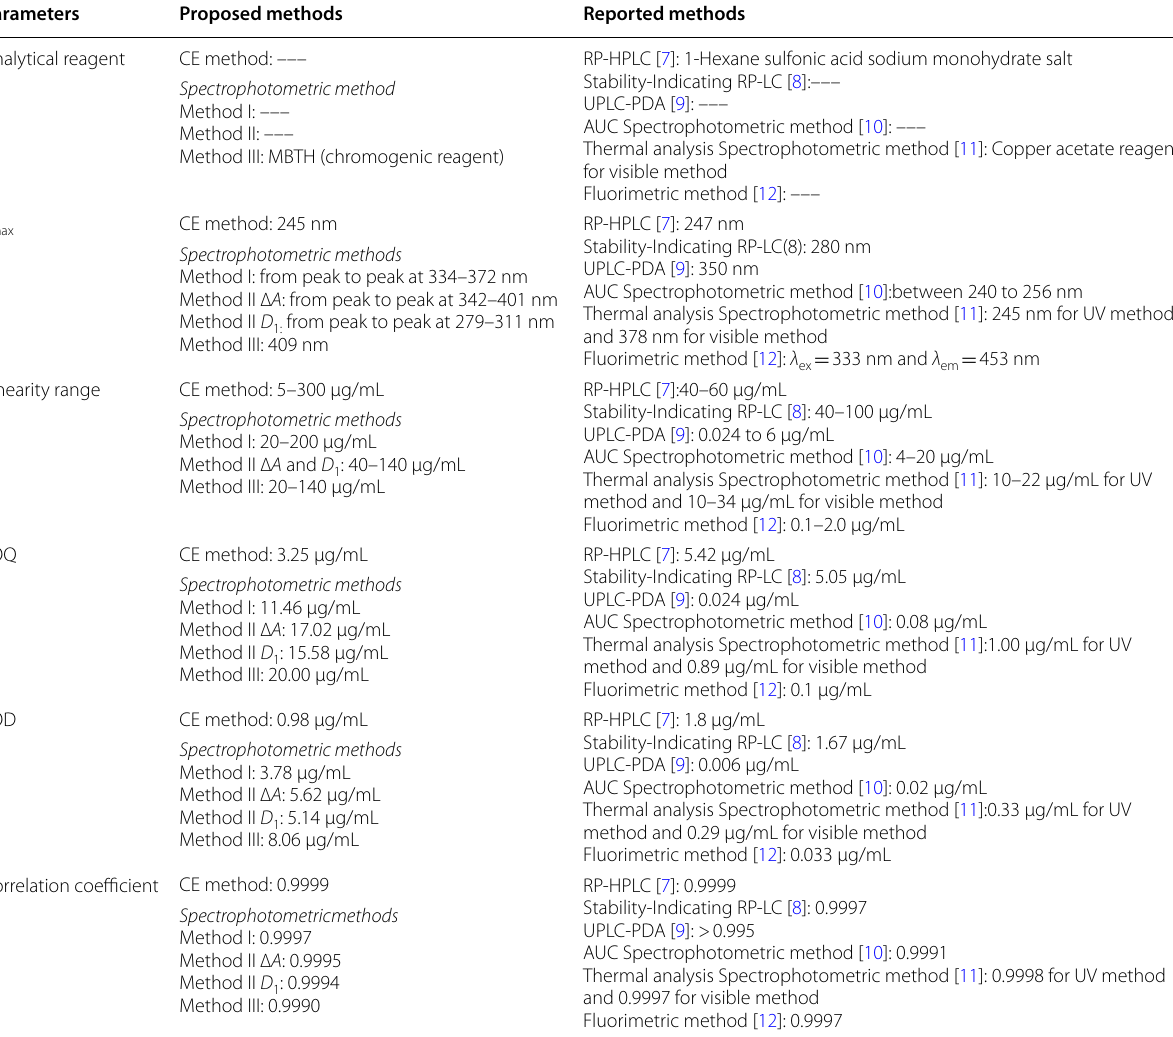
Table 6 Comparison of the proposed methods to other reported methods for TIG determination in intravenous infusion solution